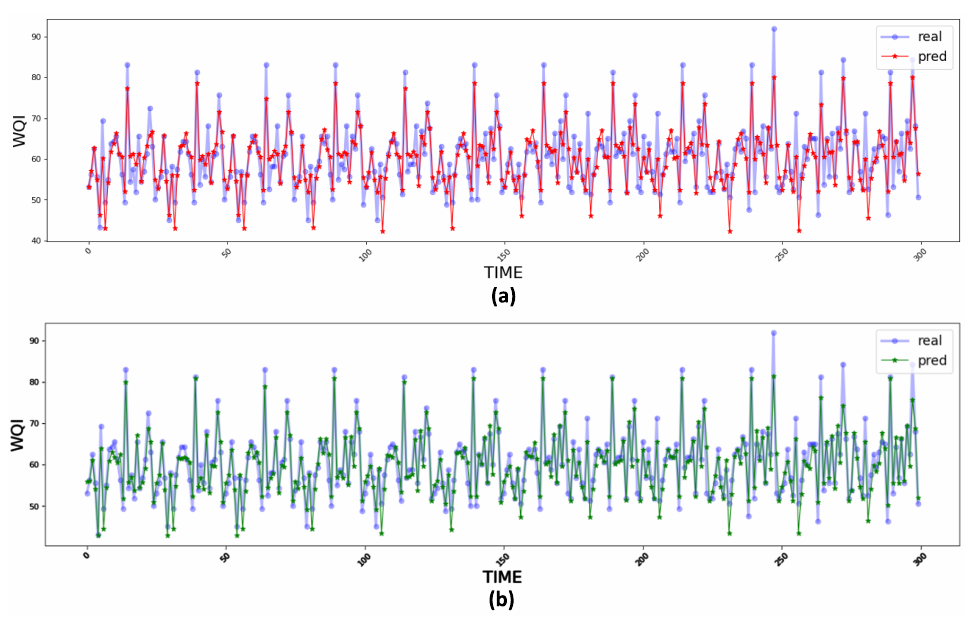
Figure 7. Observed and predicted time variation of WQI values using the best performance model based on the LSTF algorithm during the test period: ( a ) Informer-S8 ( b ) FEDformer-S9.